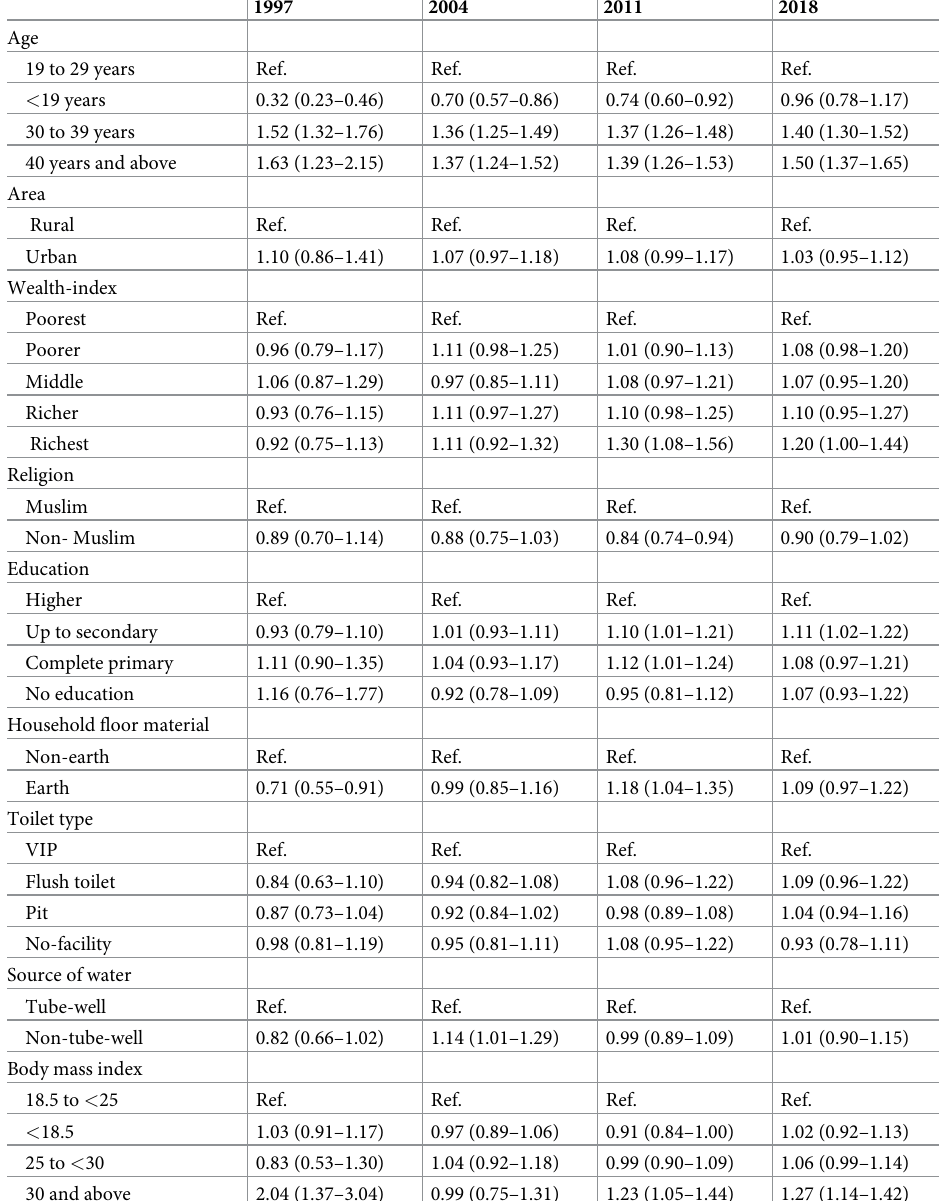
Table 2. Multivariable analysis 1 between different factors and fatal pregnancy termination at different time points among Bangladeshi women at the reproductive age